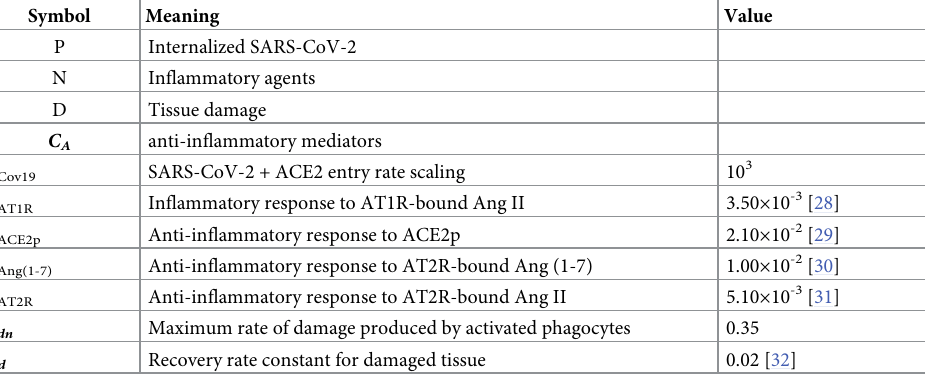
Table 4. Predicted variables and parameters for immune response. Baseline values are given for model